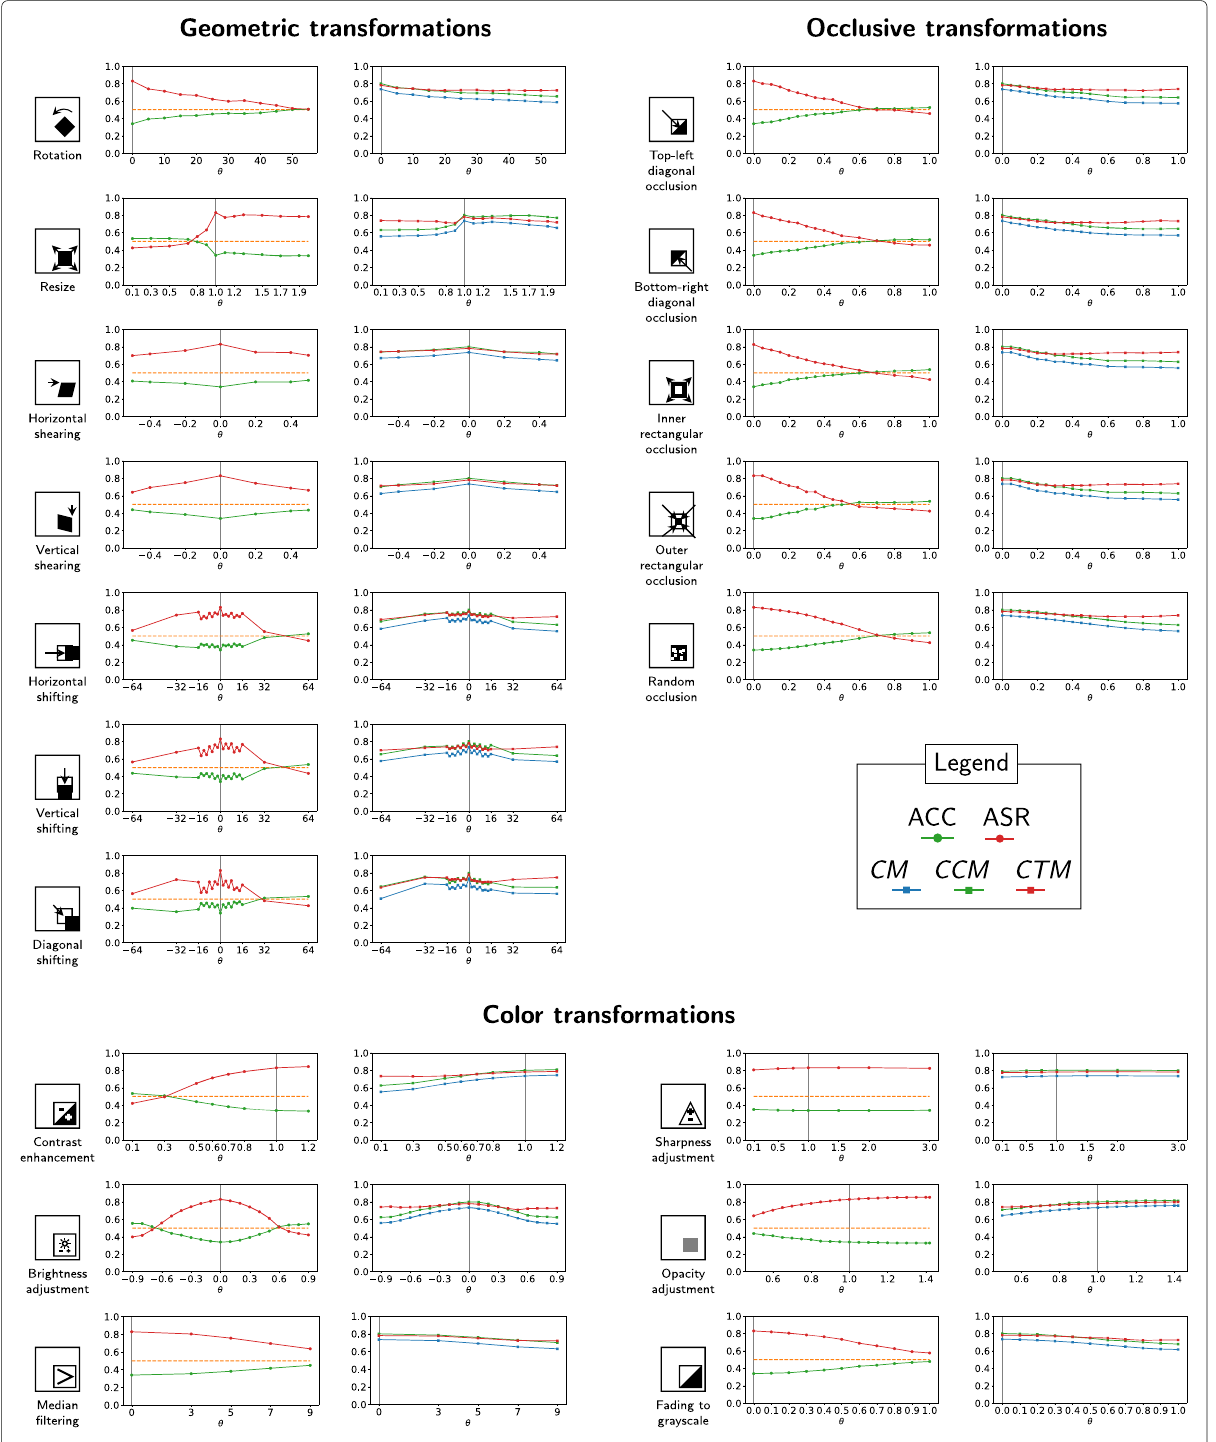
Fig. 11 Experimental results for different transformation functions for the age recognition task. In each case, represented by the corresponding icon, we plot the performance metrics as functions of the transformation parameter θ . The left plots report ACC and ASR (in green and red, respectively), and the right plots reports the average confidence values CM , CCM , and CTM (in blue, green, and red, respectively). The baseline case where φ θ ( · ) is the identity function is indicated with a vertical gray